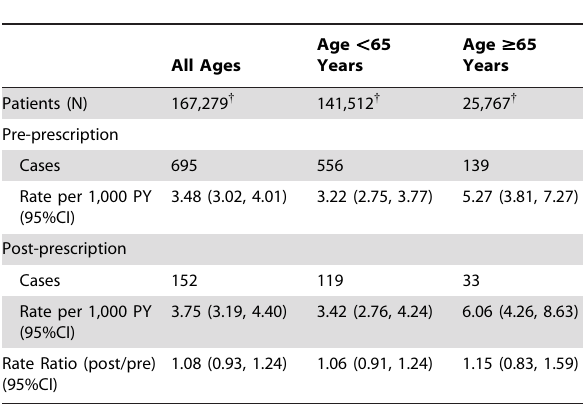
Table 3. Rates of myocardial infarction per 1,000 persons per year (PY) in men under age 65 years and those age 65 years and older, in pre- and post-prescription intervals for an initial prescription for PDE5I with adjusted * rate ratios (RR), and 95% confidence intervals